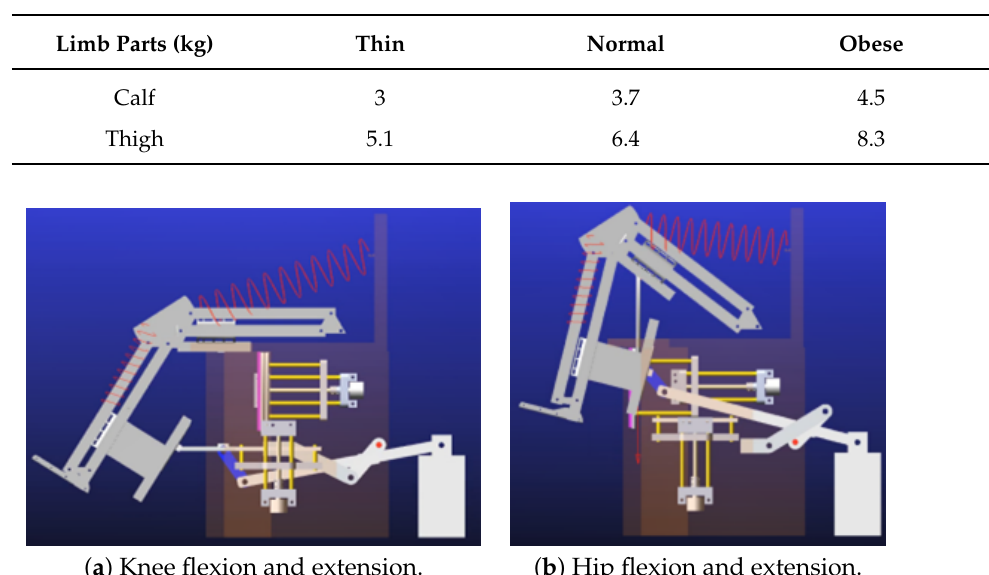
Table 7. Lower limb weights of patients with different body types.